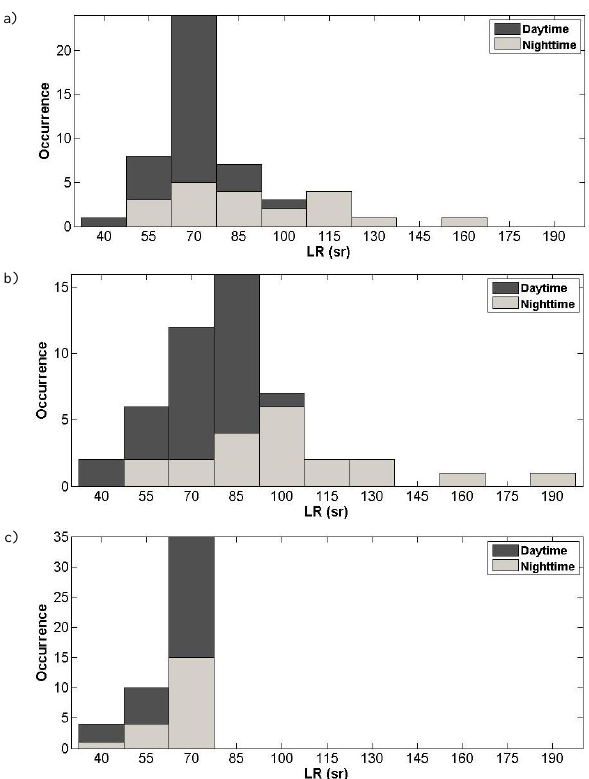
Fig. 9: Occurrences for coincident aerosol LR values (49 data) from (a) CALIOP/MODIS- Fig. 9. Occurrences for coincident aerosol LR values (49 data) Aqua synergy, (b) CALIOP/MODIS-Terra synergy and (c) operational products of CALIOP from (a) CALIOP/MODIS-Aqua synergy, (b) CALIOP/MODIS- level-2 for daytime (dark gray), nighttime (light gray). Terra synergy and (c) operational products of CALIOP level-2 for daytime (dark gray), nighttime (light